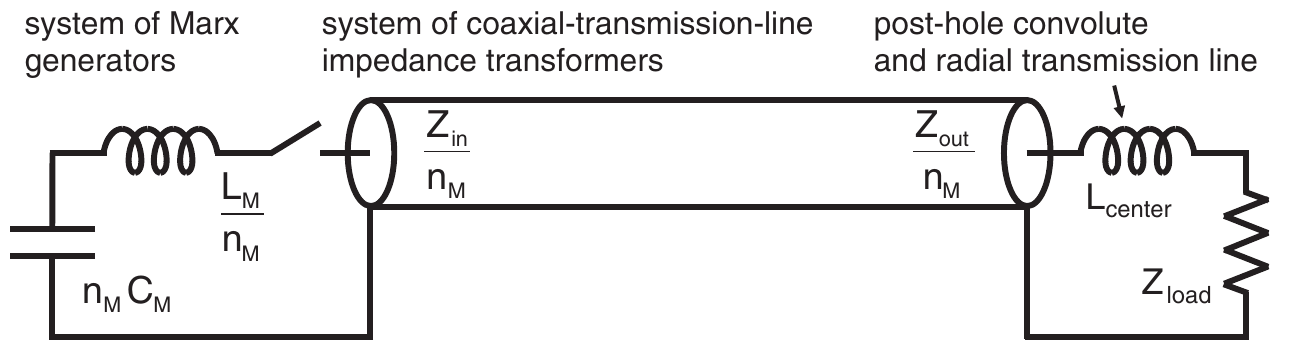
FIG. 10. Idealized version of the Neptune-circuit model illustrated by Fig. 5. The circuit presented here assumes all the Neptune Marx generators are triggered ¼ 0 , peak load current. We observe that when L center Eq. (A5) gives the result expected from elementary trans- ¼ 0 , Eq. (A5) is consistent mission-line theory; when Z load with Eq. (C18) of [43].